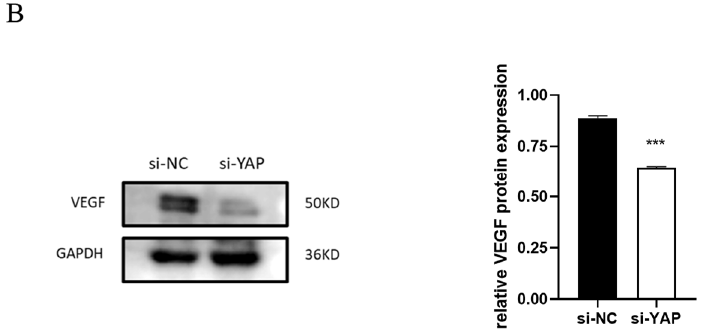
Figure 5. YAP-mediated VEGF expression from HTR-8 cell is essential for tube forming capability of HUVECs. HUVECs were seeded onto Matrigel and incubated with culture supernatant from HTR-8 cells transfected with scrambled siRNA or YAP siRNA. ( A ) The tube formation assay was analyzed after 3 h. Representative images are shown. Scale bars are 100 µ m. ( B ) The VEGF protein expression in HTR-8 cells 72 h after transfection with scrambled siRNA and YAP siRNA was measured by immunoblotting (normalized to GAPDH). Results are shown as mean ± SEM. Student’s t test; *** p < 0.001, **** p < 0.0001).